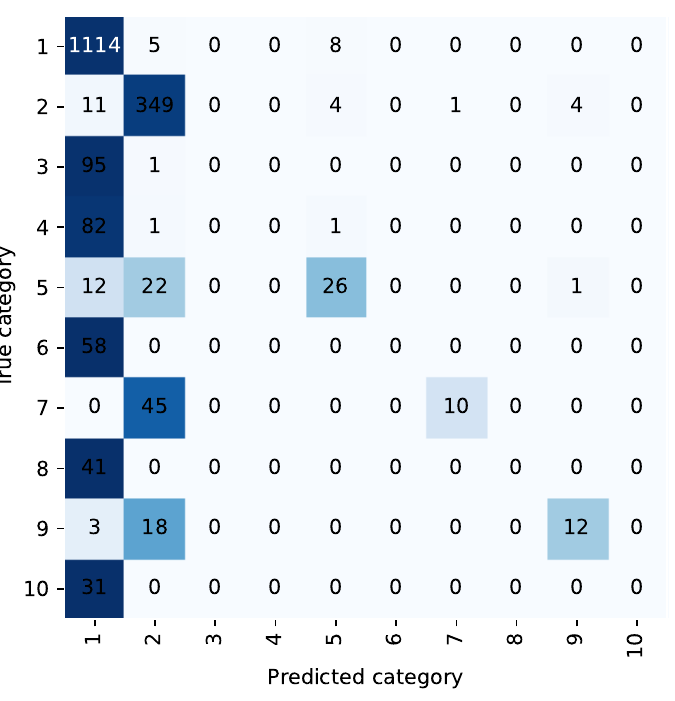
Figure 2. Confusion matrix of LP